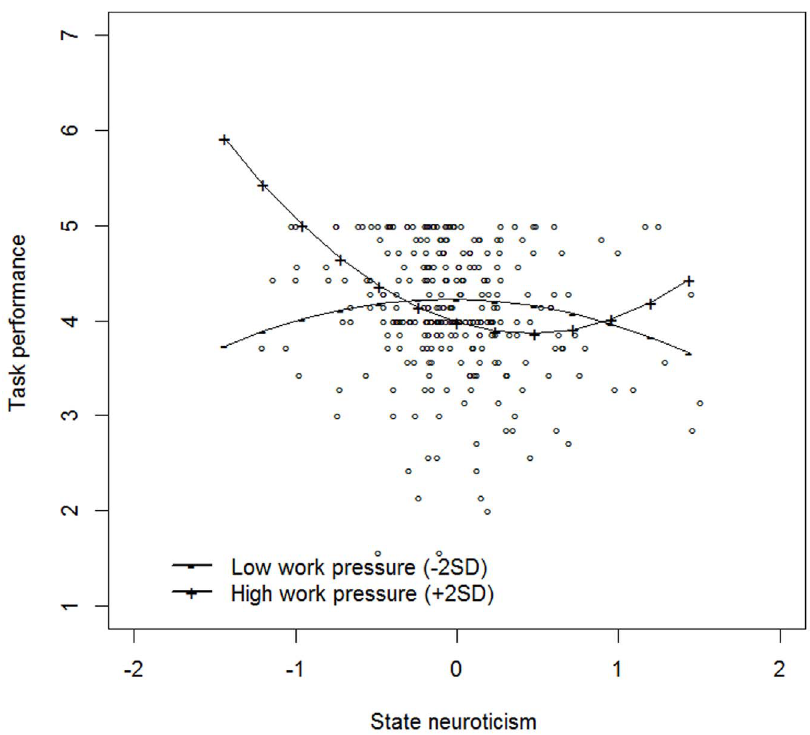
Figure 2. The moderating effect of low ( 2 2 SD ) and high ( + 2 SD ) levels of momentary work pressure on the state neuroticism – task performance relationship (Study 2).